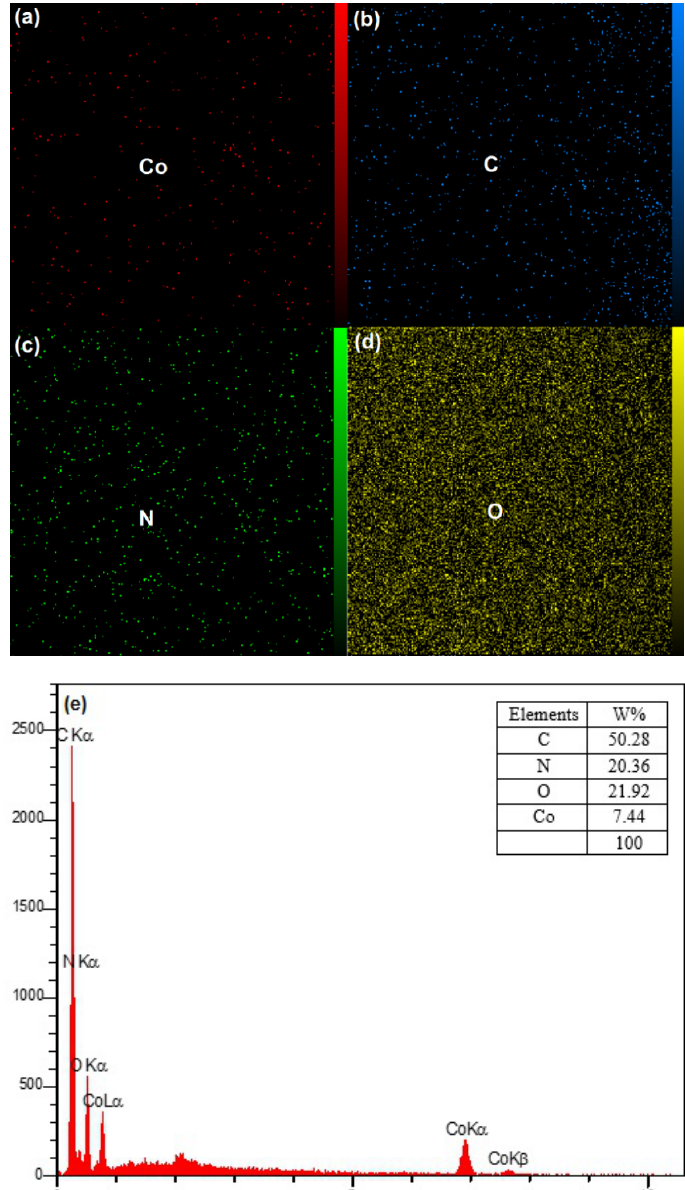
Figure 1. ( a – d ). Energy-Dispersive X-ray (EDX) mapping; ( e ) EDX spectra of nanoparticles in graphene oxide (GO)/ZIF-67 nanocomposites.